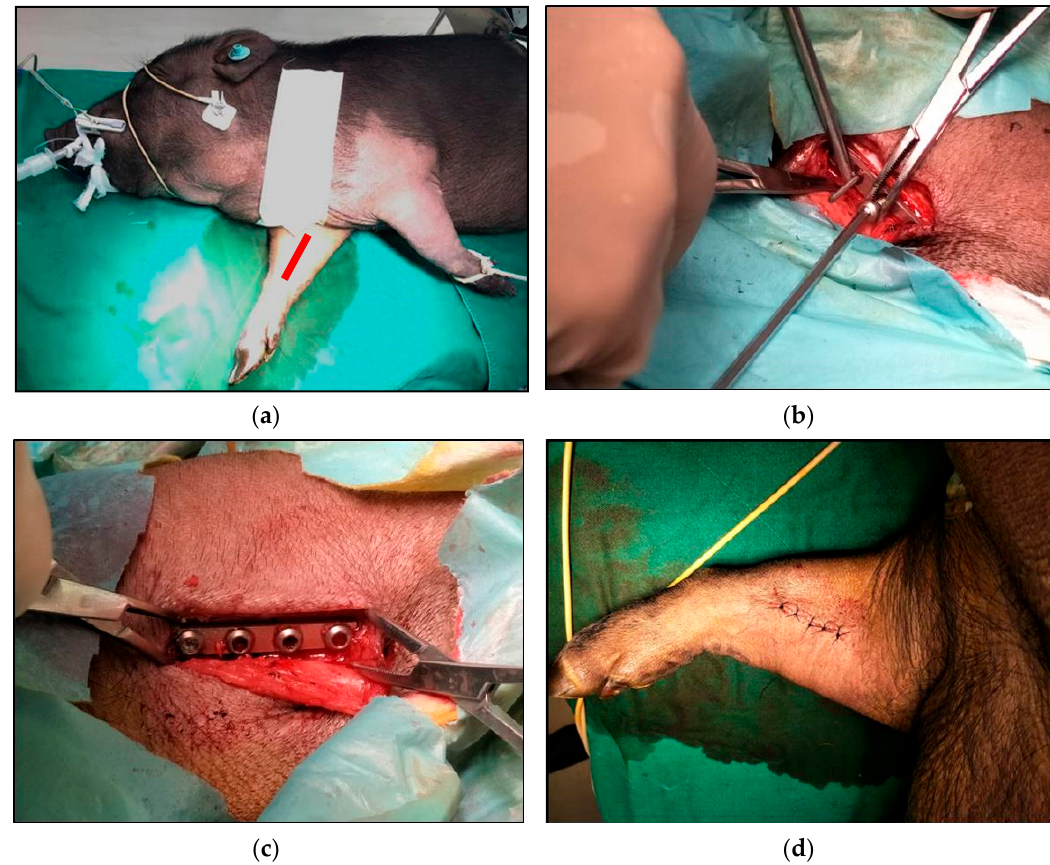
Figure 3. In vivo test of ZKX500 Mg bone plate and screws: ( a ) animal on the operation table with red line denoting the incision position, ( b ) insertion of a magnesium screw into the magnesium bone plate, ( c ) complete insertion of the screw, and ( d ) appearance of the animal after suturing of the wound.